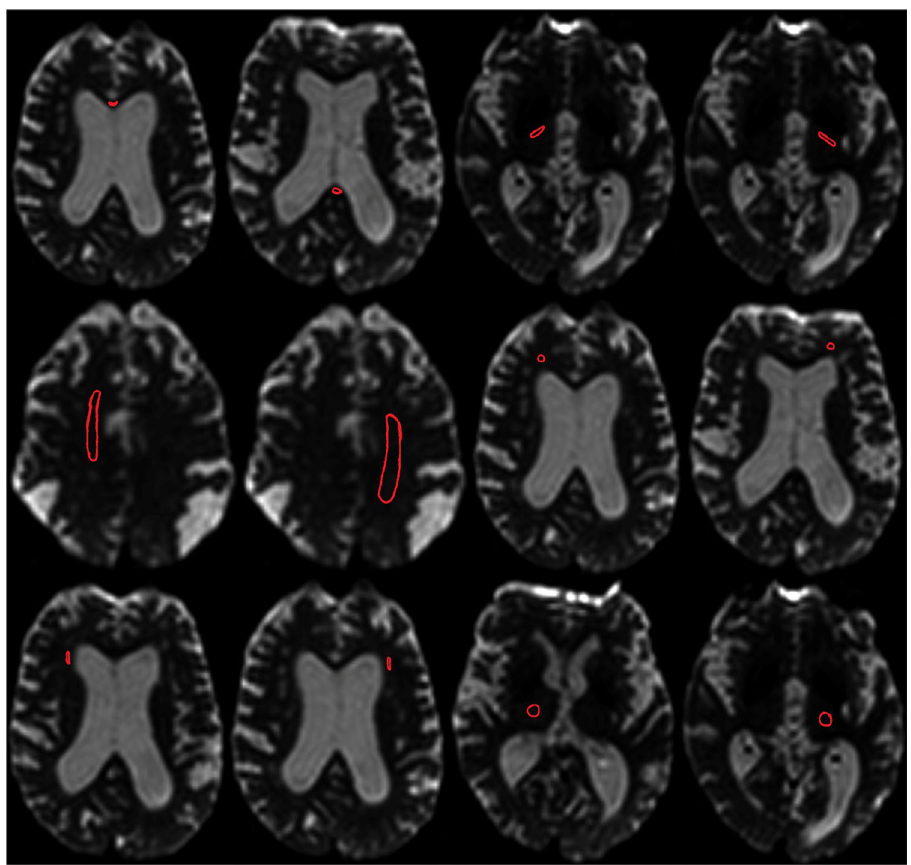
Figure 1. 12 ROIs along the corpus callosum (CC) (genu and splenium), capsula interna right and left (CIdx, CIsin), centrum semiovale right and left (CSdx, CSsin), one in the frontal white matter right and left (FWMdx, FWMsin) one in the lateral frontal white matter right and left (LWMdx, LWMsin) and one in the thalamus right and left (THdx,